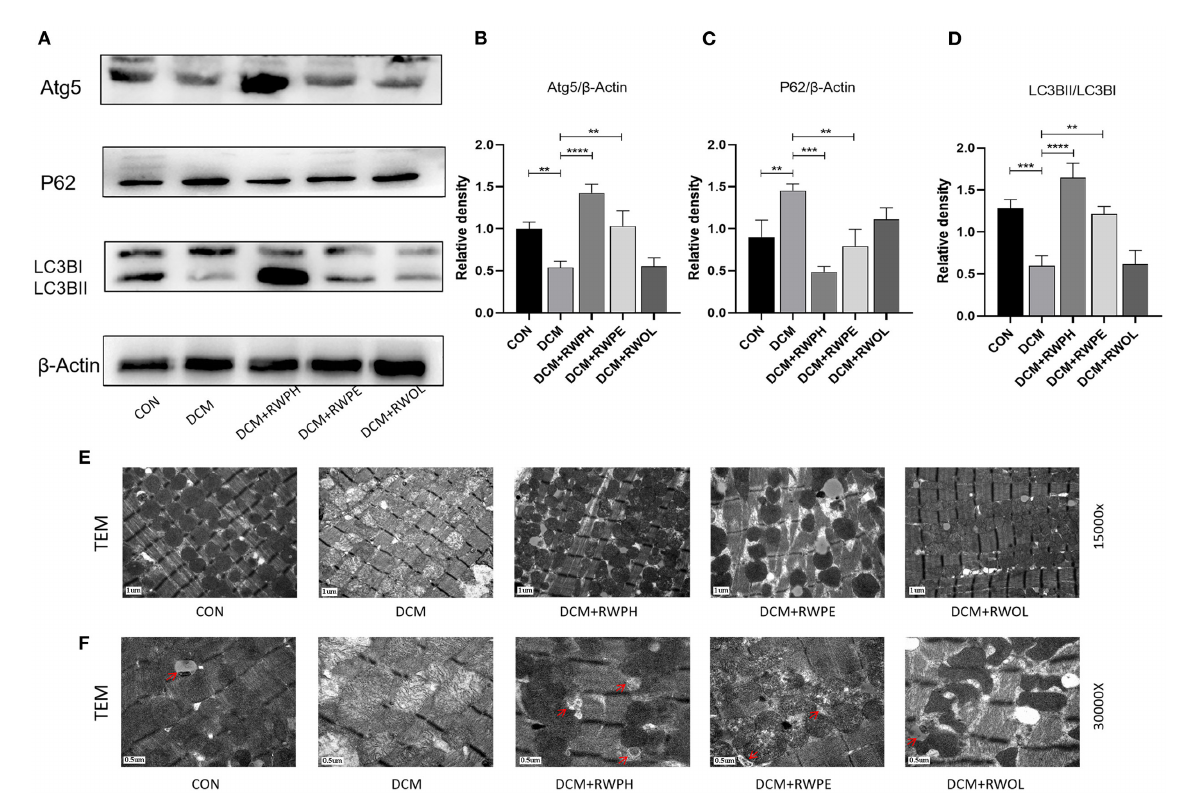
FIGURE3 RWPH and RWPE clear dysfunctional mitochondria through enhanced autophagy in DCM mice. (A–D) Western blot analysis of the relative protein expression of ATG5, P62, and LC3B in myocardial tissue. (E) Transmission electron microscopy of left ventricular specimens showing mitochondria with different pathological forms. (F) the autophagosomes of each group under transmission electron microscopy, which are pointed out by red arrows. ** P < 0.01, *** P < 0.001, and **** P <